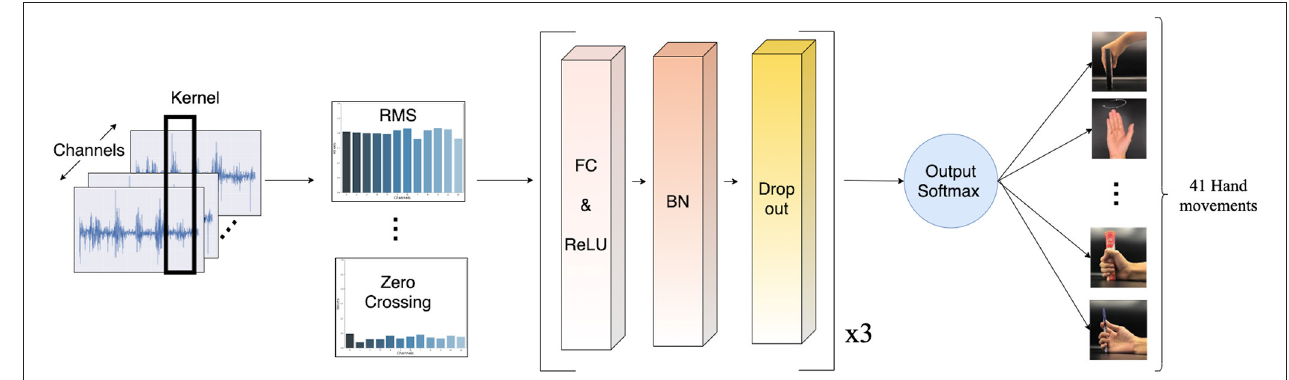
FIGURE 5 | Schematic of the proposed deep neural network model. The sEMG input is segmented by a sliding window. Then, the features are extracted and normalized before passing into the classifier. Lastly, a softmax activation function turns the classifier’s output into a probability-like vector for the classification of 41